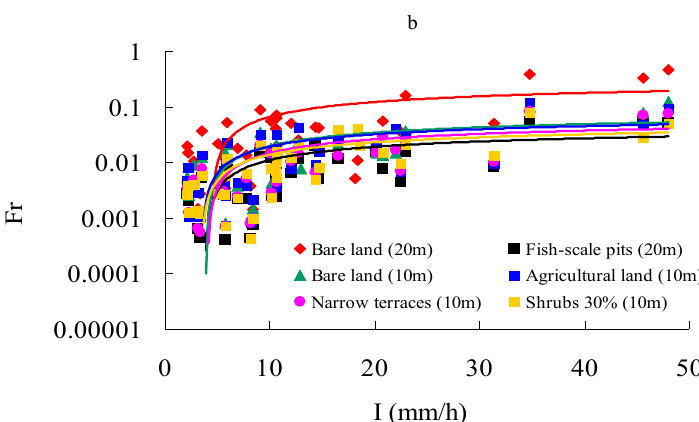
Figure 4. Relationship between I (average rainfall intensity) and Re and Fr ; ( a ) relationship between Re and rainfall intensity; ( b ) relationship between Fr and rainfall intensity.